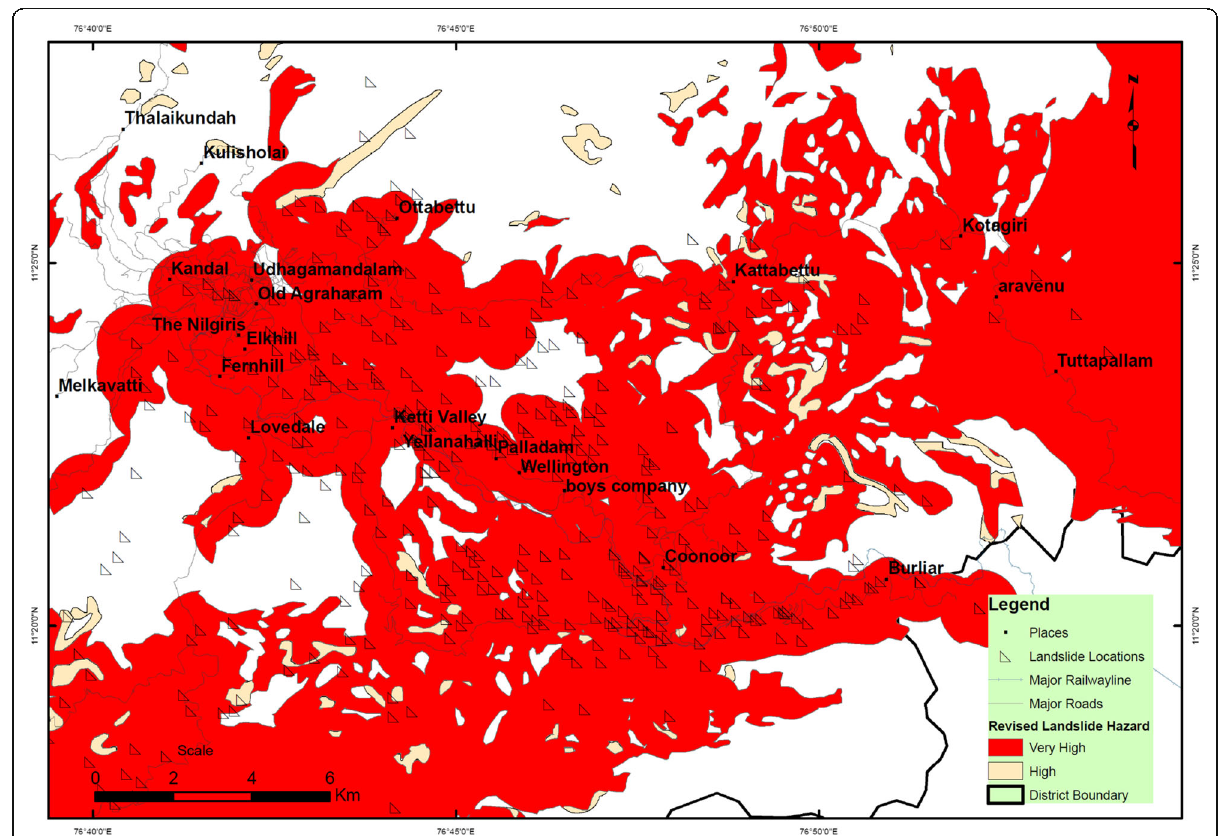
Fig. 7 Landslide Hazard Zonation map of the Nilgiris